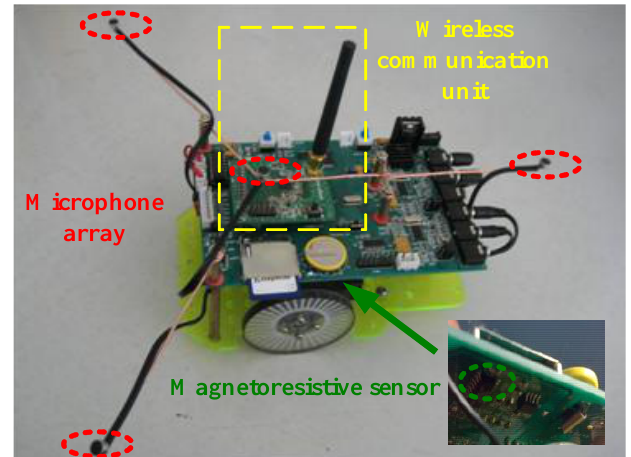
Figure 5. Photograph of hearing